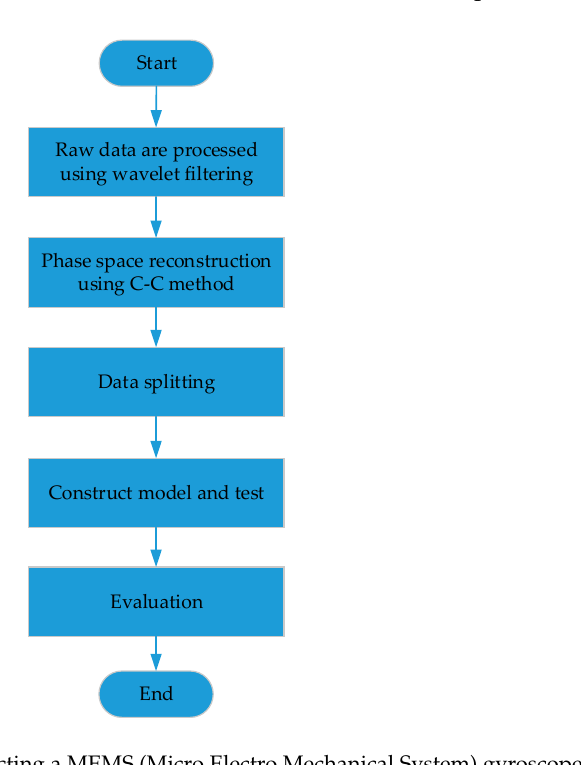
Figure 5. The flow chart of constructing a MEMS (Micro Electro Mechanical System) gyroscope model.